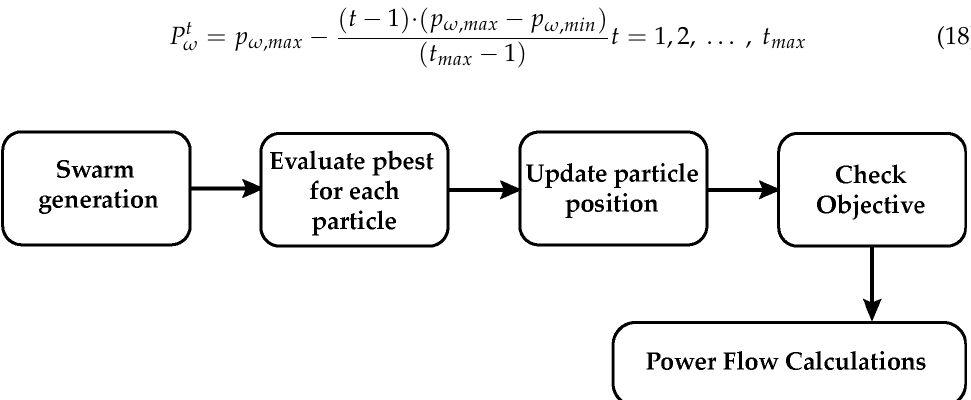
Figure 7. Simplified illustration of PSO and Power Flow co-simulation by Gomez-Gonzalez et al.